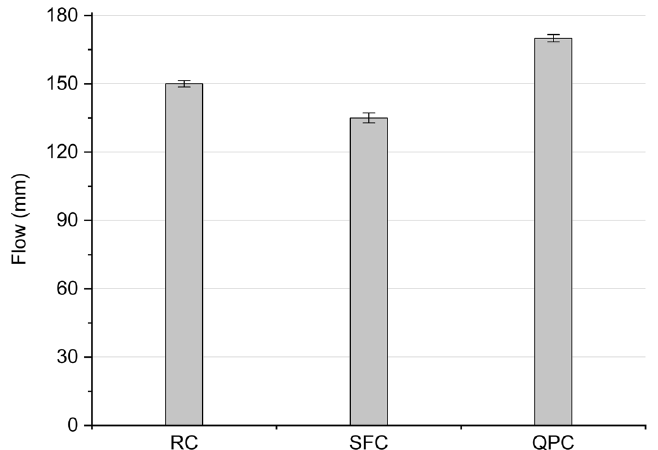
Figure 3. Flow table of RC, SFC and QPC composites.